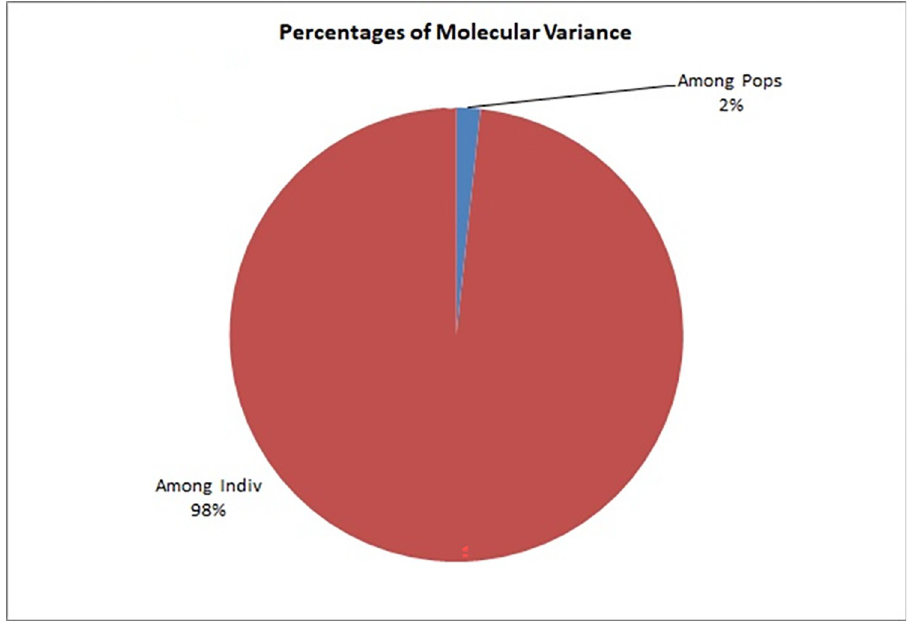
Fig 4. Analysis of molecular variance (AMOVA) of Indian mustard cultivars based on SSR data.